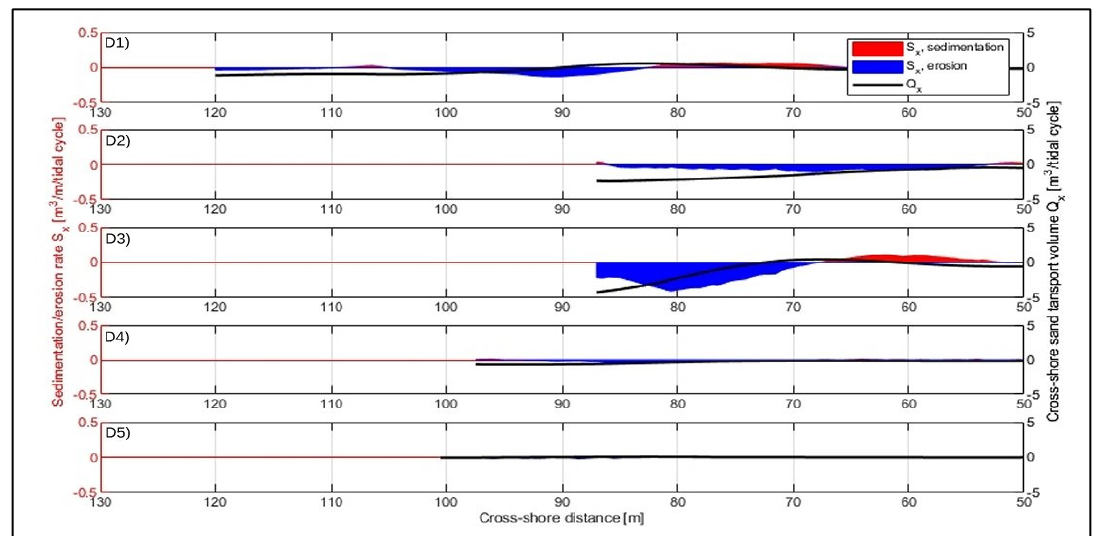
Figure 15 . Low waterbed levels for period D (M4 and M5 in Figure 7) from 21 to 25 February 2017 (excluding 22 February). The dashed lines indicate the total high water level after each subsequent low water period. D1–D5 indicates time periods shown in Figure 16.